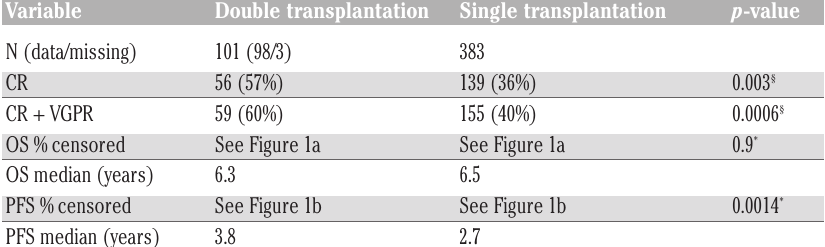
Table 2. Comparison between double and single transplantation.